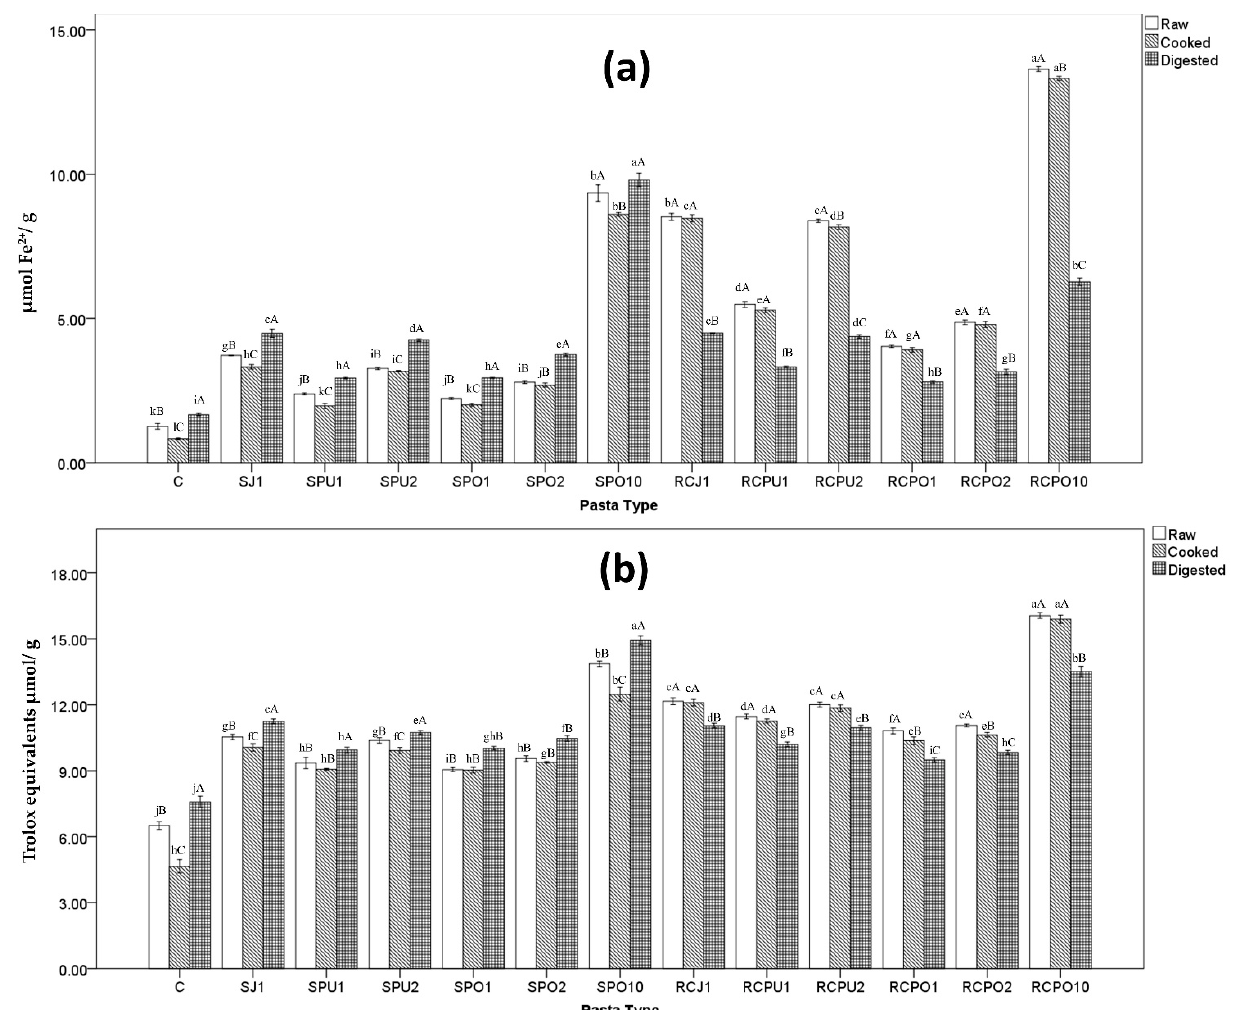
Figure 2. FRAP ( a ) and ABTS ( b ) value of vegetable pasta, SJ, SPU, SPO represent spinach juice pasta, spinach puree pasta, spinach pomace pasta, respectively; RCJ, RCPU, RCPO represent red cabbage juice pasta, red cabbage puree pasta, red cabbage pomace pasta, respectively; C: control sample, 1, 2 and 10 is the substitution level (g/100 g or %) based on dry weight. The same lowercase letters are not significantly different from each other ( p > 0.05) for the same states of pasta (raw vs. raw, cooked vs. cooked, digested vs. digested). The same uppercase letters are not significantly different from each other ( p > 0.05) for the same kind of pasta (raw vs. cooked vs. digested).